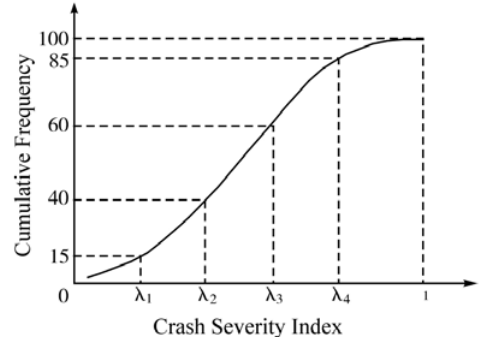
Fig.8. Crash Severity Cumulative Index